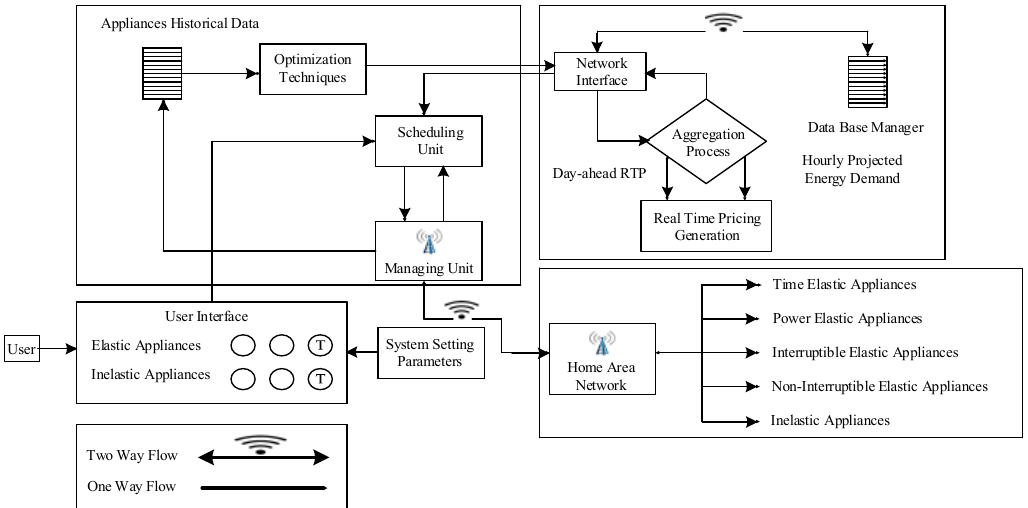
Figure 3. Functional model: ECSU exchanges the schedule with the utility to optimally control the consumer’s consumption